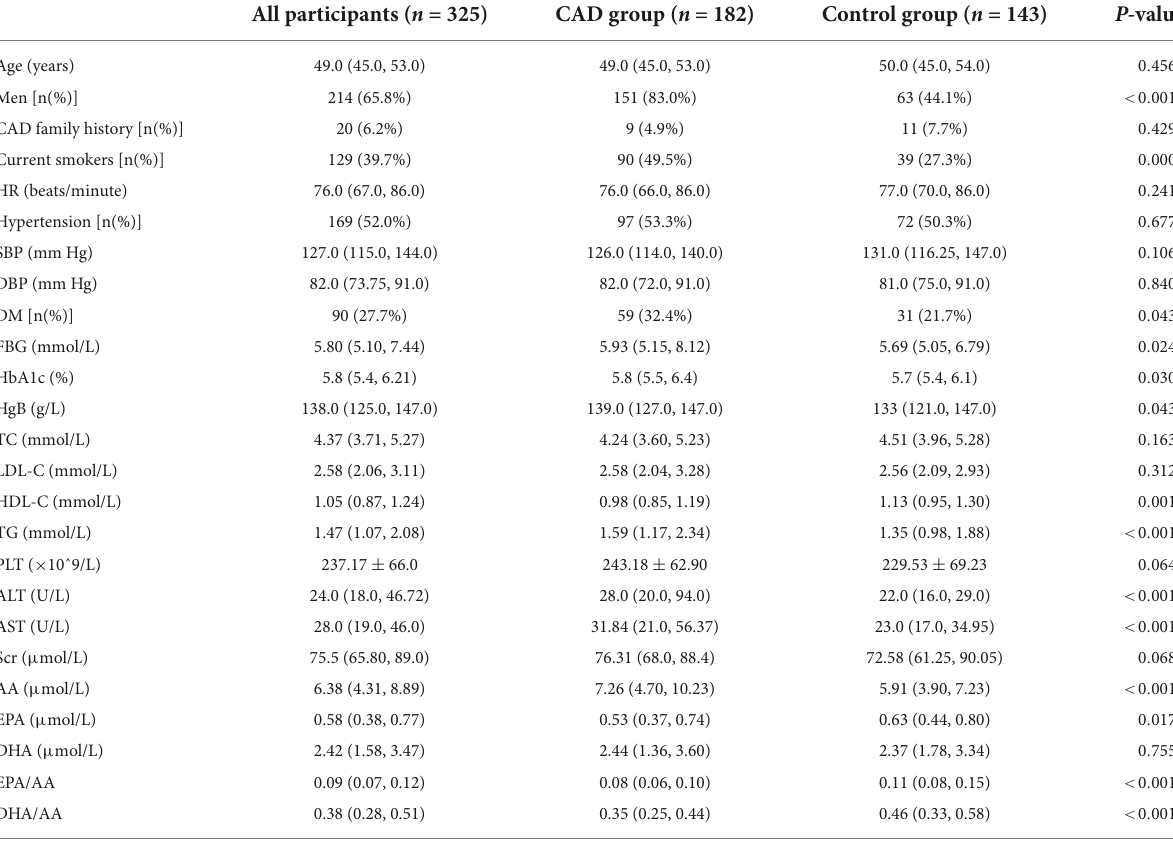
TABLE 1 Demographic and clinical characteristics of CAD patients and